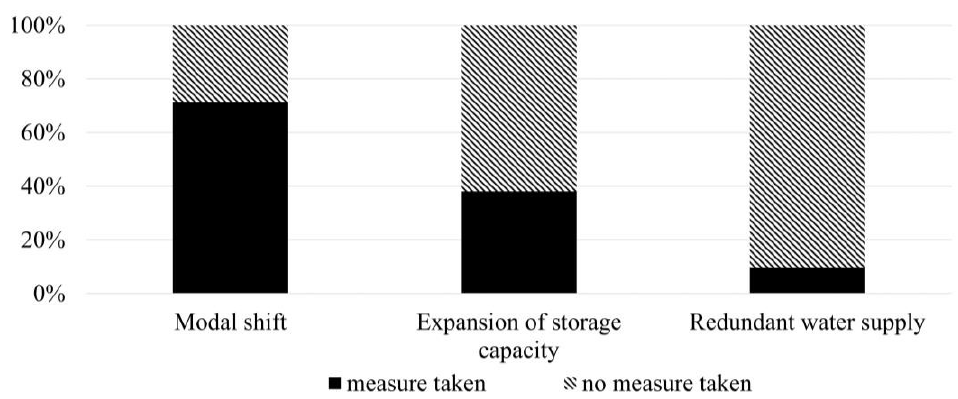
Figure 13. Measures to reduce risks arising from waterways.